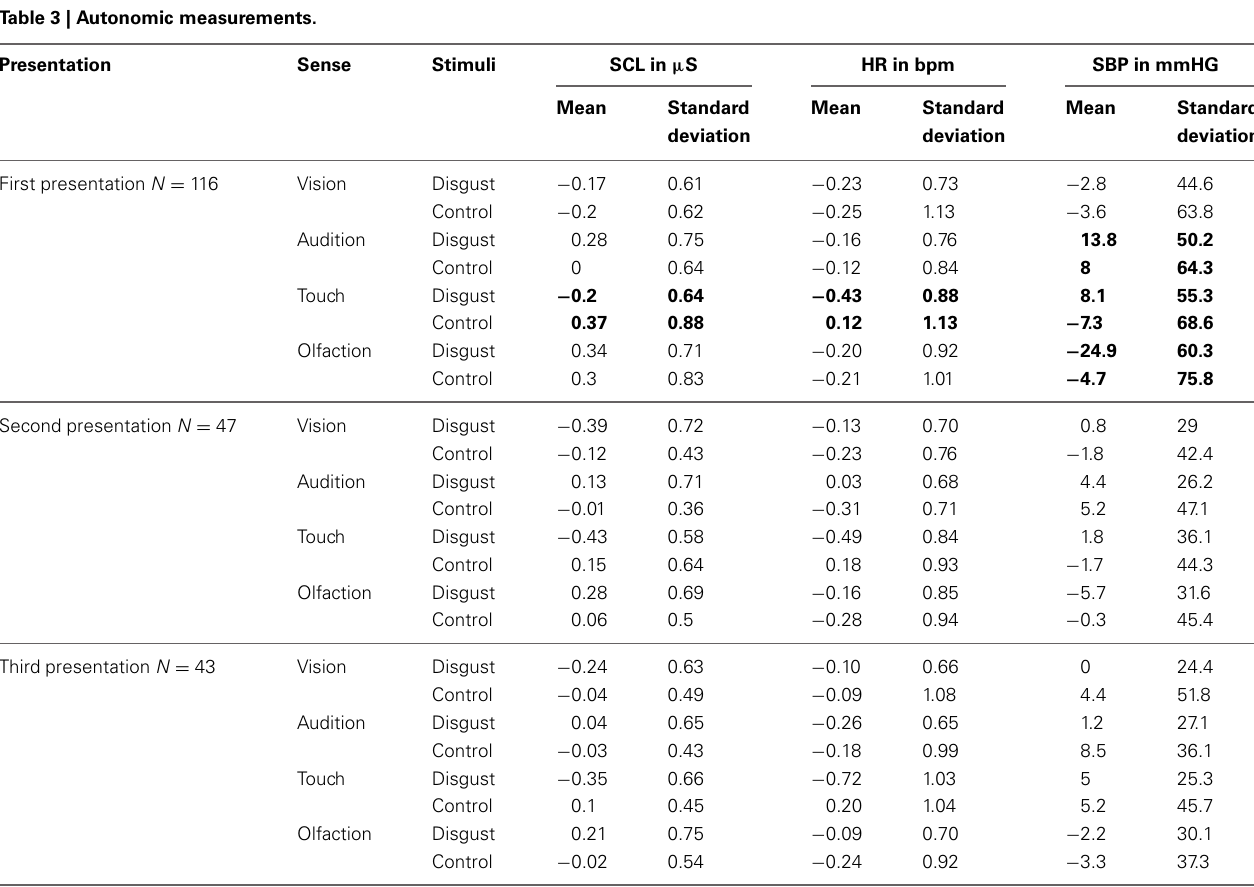
Table 3 | Autonomic